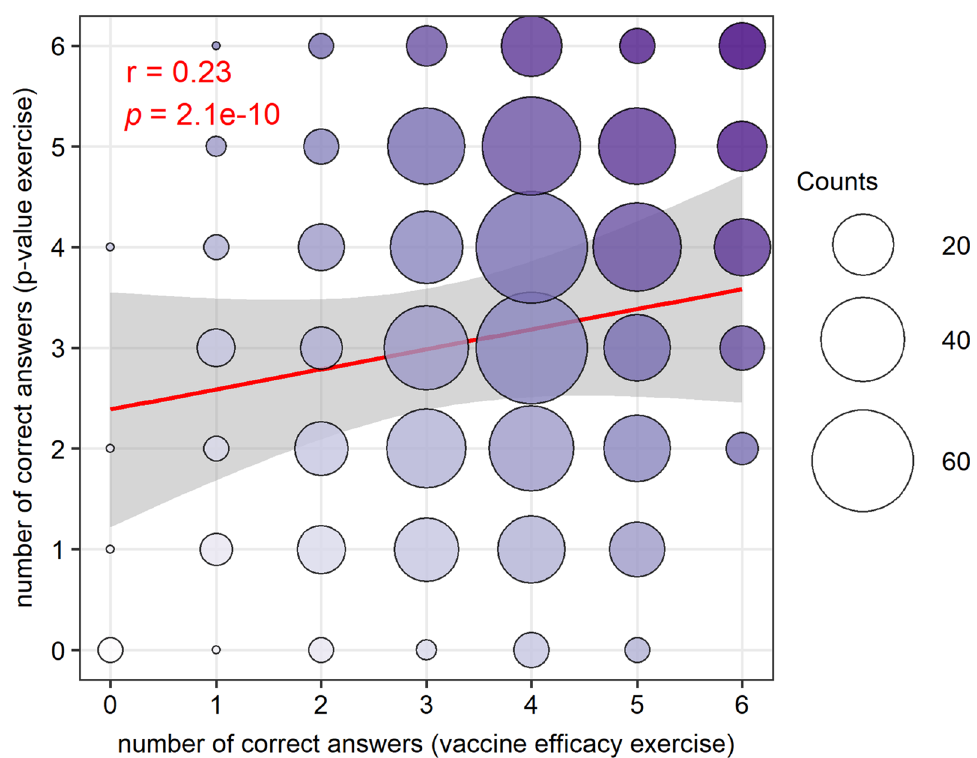
Fig. 4 Bubble plot with regression line of the number of correct answers on the p value exercise as a function of number of correct answers on the vaccine efficacy exercise. There were six claims in each exercise. Performance correlated on the two exercises across participants (r and p indicate Pearson’s correlation coefficient and statistical significance). The red line represents the linear regression line with shaded gray area illustrating the 95% confidence interval. The circles are proportional to the number of responses in each of the cases and are for display purposes. The color intensity increases with the number of correct answers over the two exercises (from 0 in white to 12 in dark purple). All participants that completed both exercises are pooled together for this analysis (N 756). Performance (number of correct answers out of the 6 claims) correlates between the = exercises focusing on vaccine efficacy and p